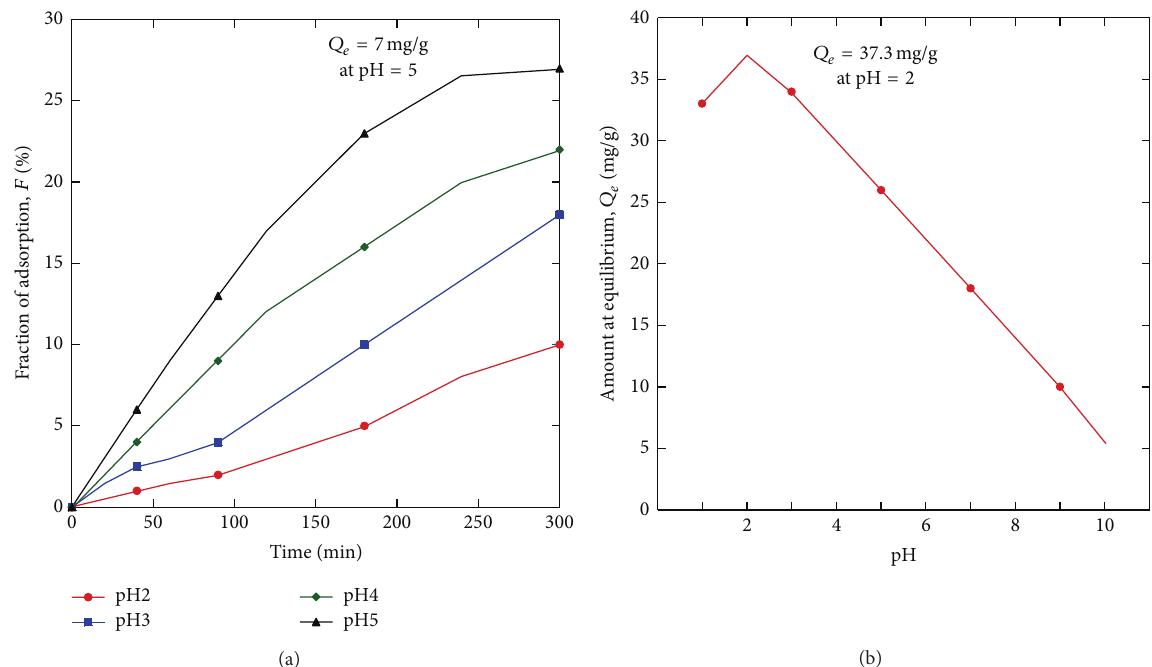
Figure 4: Sorption efficiency of copper ion (a) and equilibrium amount of chromate ion per unit mass of polymer (b) at different pHs.